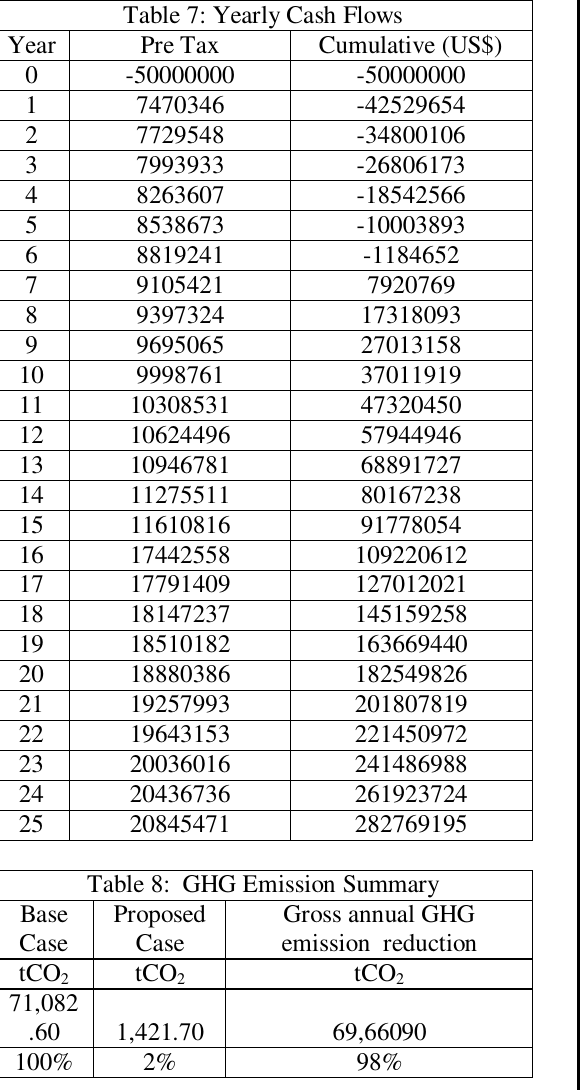
Table 8: GHG Emission Summary